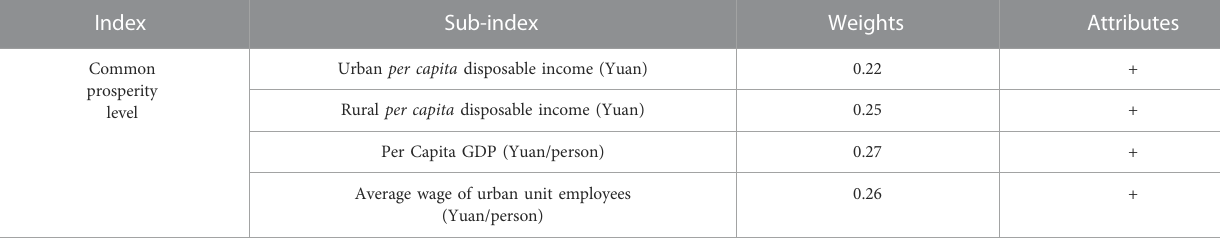
TABLE 1 System of common prosperity indicators.